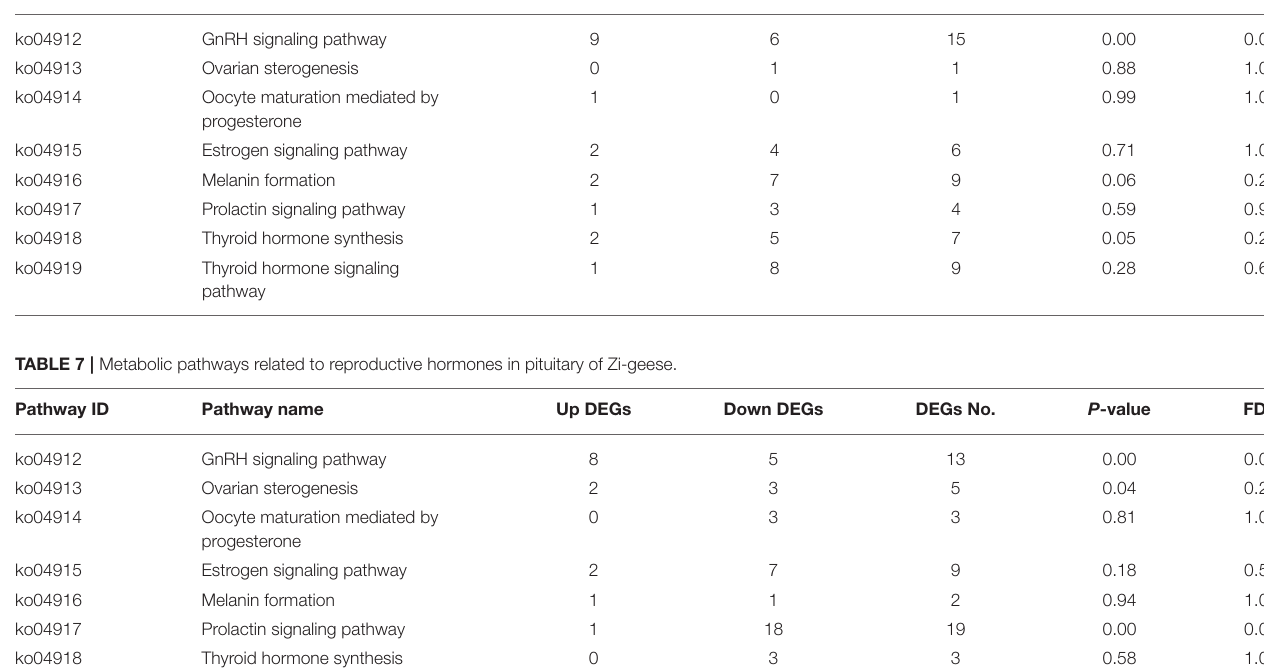
TABLE 6 | Metabolic pathways related to reproductive hormones in hypothalamus of Zi-geese. Pathway ID